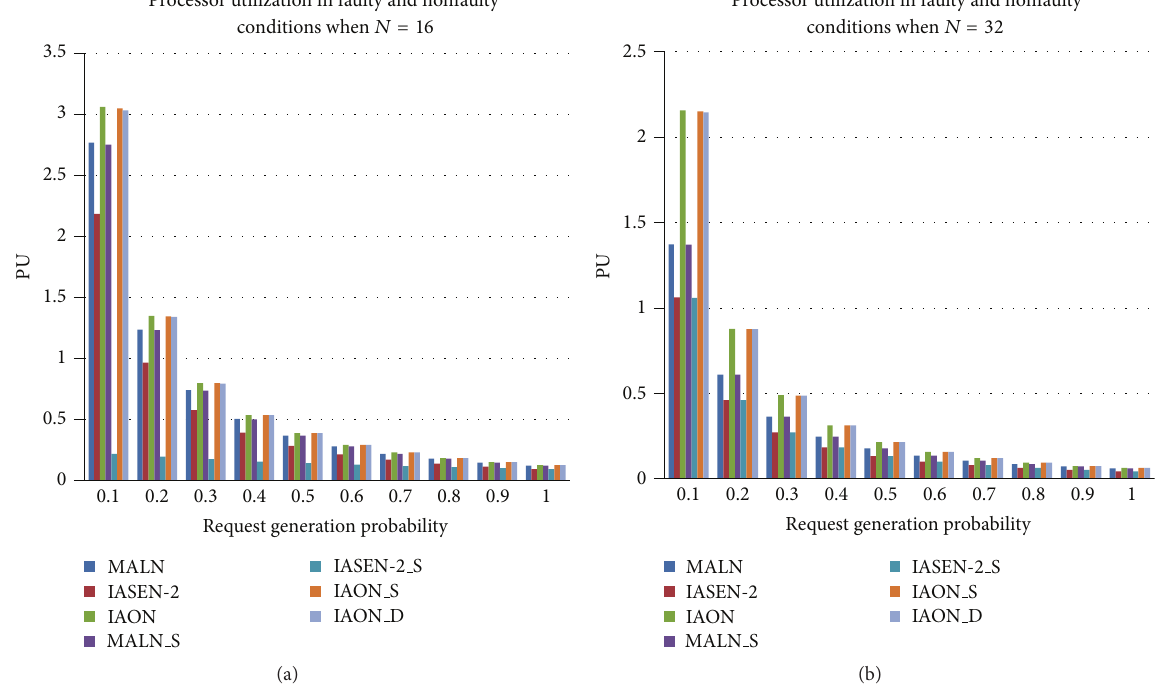
Figure 12: The processor utilization of MALN, IASEN-2, and IAON in faulty and nonfaulty cases, when the network sizes are 16 and 32 separately.